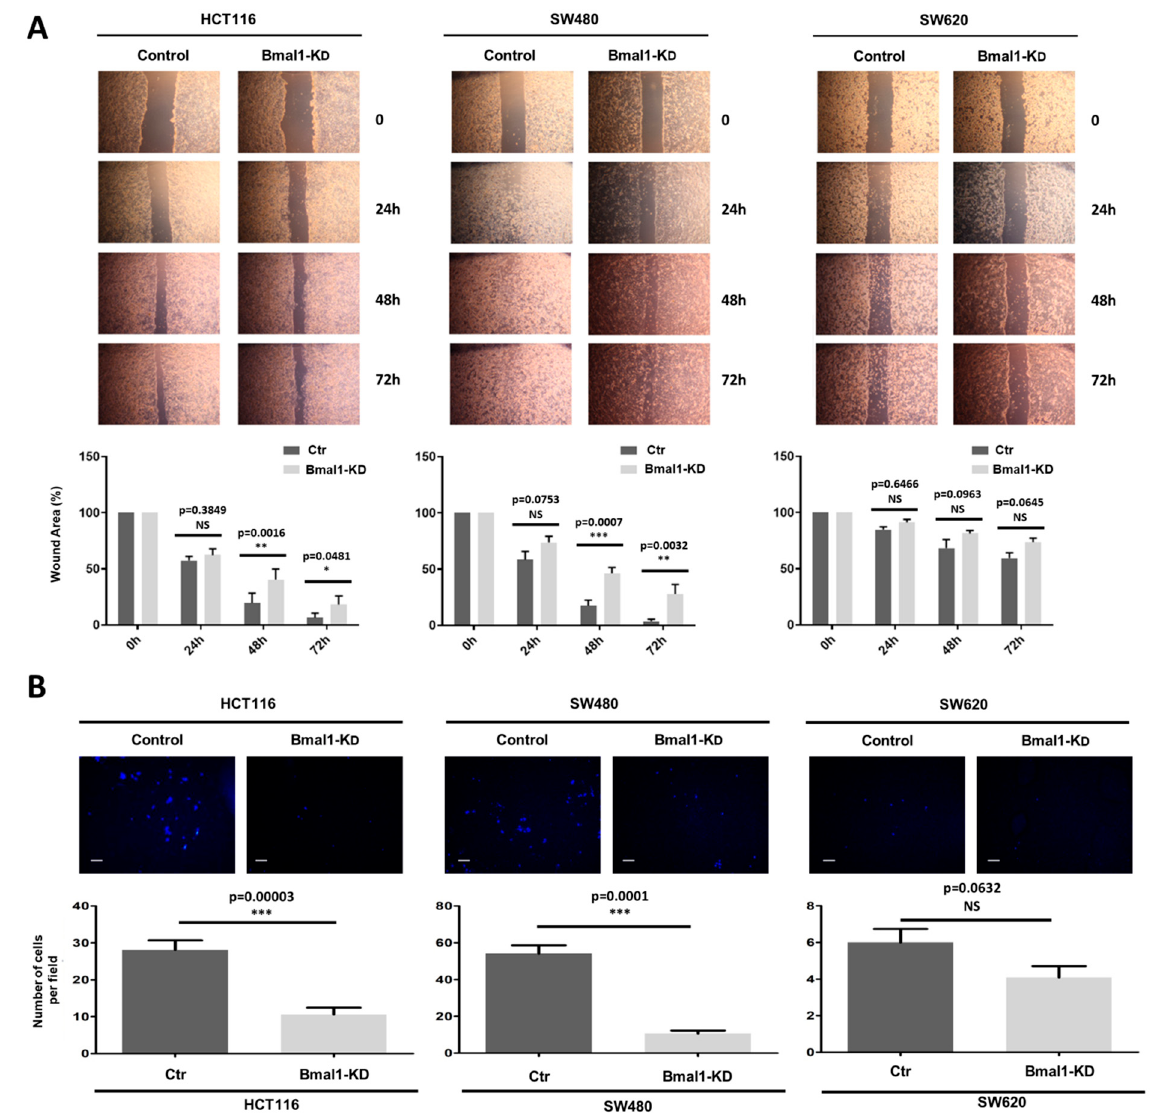
Figure 5. BMAL1-KD inhibits cell migration and invasion of CRC cell lines. ( A ) A scratch-wound healing assay was applied for cell migration assay. Top, Artificial wounds were made in confluent monolayers of control and BMAL1-KD CRC cell lines. Migration of CRC cells towards the wound, photographed from 24 h to 72 h. The top panel shows one of three independent experiments. Bottom, HCT116 BMAL1-KD and SW480 BMAL1-KD cells displayed lower levels of migratory activity in comparison to control cell lines ( n = 3, * p < 0.05, ** p < 0.01, *** p < 0.001). No significant differences in migratory activity were observed between BMAL1-KD and control SW620 cells. Data are shown as means ± SEM. ( B ) Invasion assay. Top, The invasive potential of BMAL1-KD CRC cell lines and their control were analyzed in Matrigel Transwells after 96 h by fluorescence microscopy. DAPI was used to stain the nuclei and to determine the number of invasive cells. A representative image of random fields is shown for each cell type. Scale bar, 50 μ m. Bottom, Graphs represent the mean of the number of invaded cells per field in three independent experiments. Only the primary BMAL1-KD CRC cells had a lower invasion capacity than control cells ( n = 3, *** p < 0.001). Data are shown as means ± SEM.